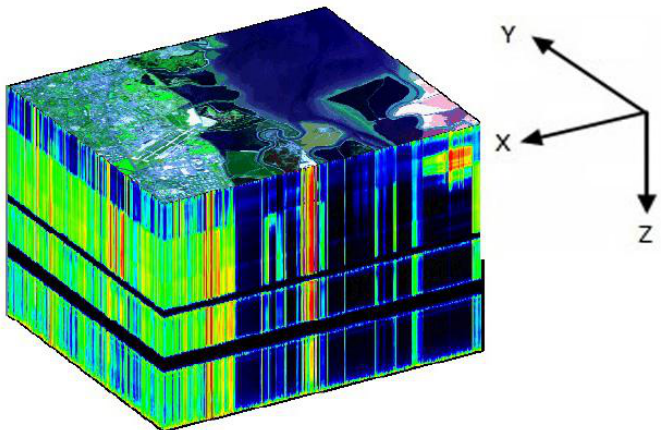
Figure 1. Example of data cube for a hyperspectral